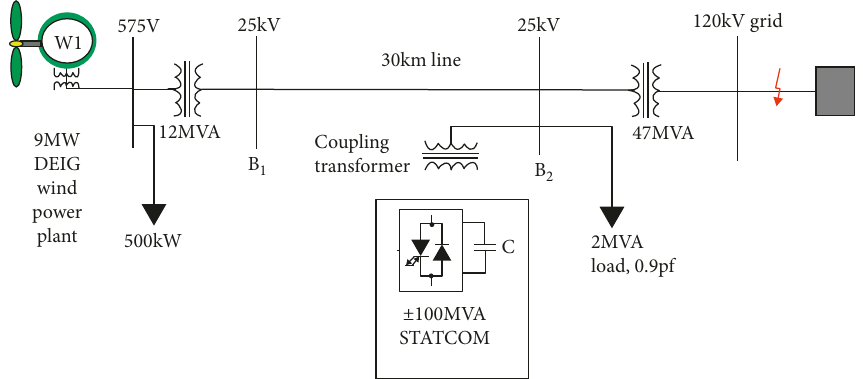
Figure 9: Single line diagram of test system [35].